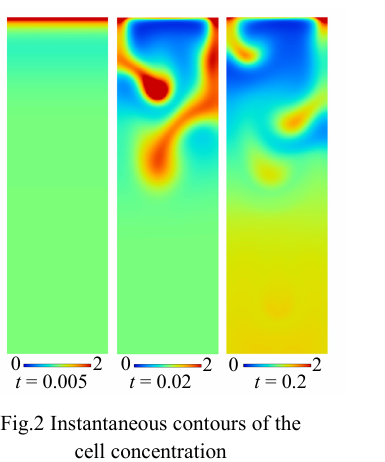
cell concentration